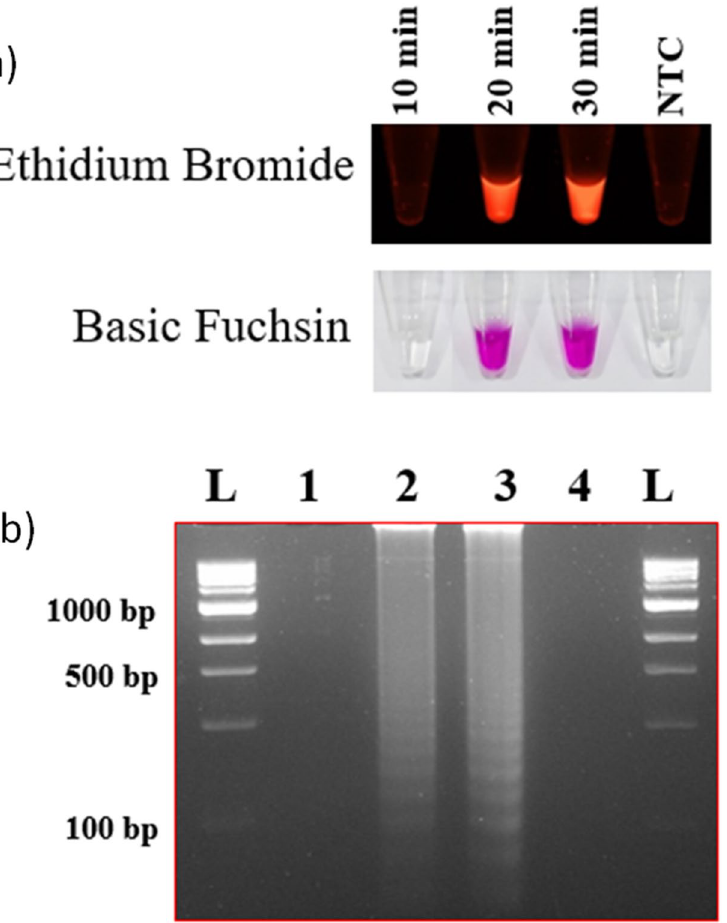
Figure 2. Reaction time optimization. Time optimization for the LAMP assay with Ethidium bromide and basic fuchsin ( a ) where NTC indicates non-template control. The results were visualized in 2% agarose gel ( b ), lane 1 to 3 indicates reaction time in min (10, 20, and 30), lane 4 indicates negative control, and the lane L indicates 1 kb ladder (Thermo Scientific,